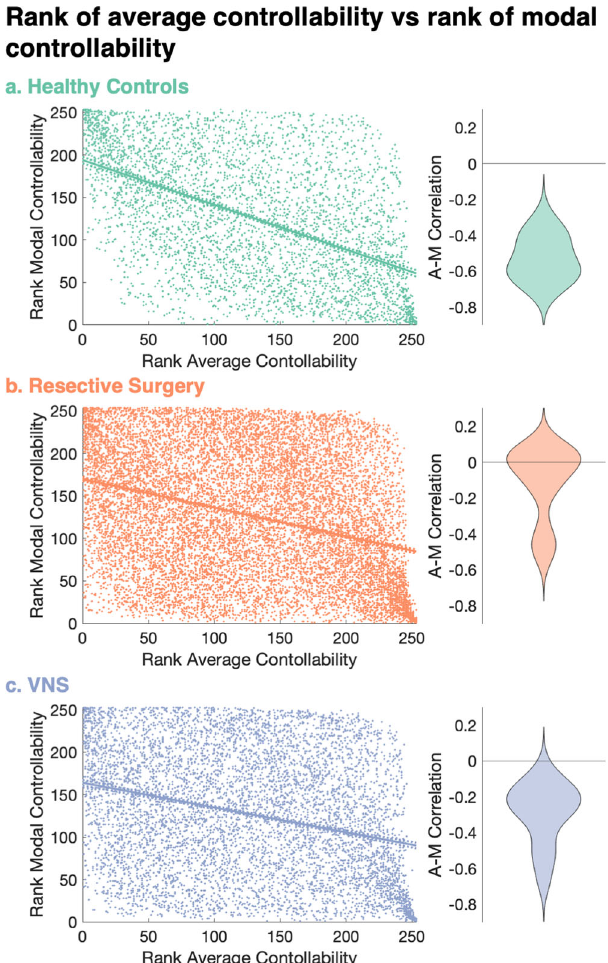
controllability is weaker in patients with drug-resistant epilepsy. a – c Correlation between the rank of average controllability and rank of modal controllability (AC-MC correlation) for each parcel across all a healthy controls, b resective surgery and c VNS patients. Lines show the linear regression best fi t (solid line) and 95% con fi dence intervals (dotted lines). Adjacent violin plots show distribution of these correlation coef fi cients for each individual subject. There were signi fi cant differences in the distributions of the correlations at the individual patient level between controls and both groups of patients ( p = 7 × 10 − 8 for resective surgery and p = 0.02 for VNS after correcting for age, sex, cognitive function, mean weighted degree and multiple